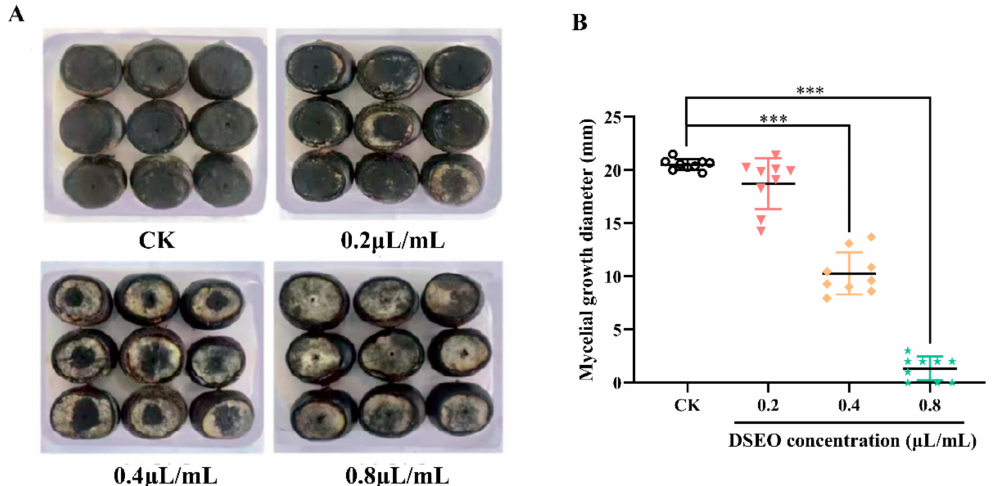
Figure 9. In vivo fumigation antifungal activity of DSEO on the growth of N. parvum . ( A ) Represen- tative photos of chestnut samples with or without DSEO treatment during 3 days of incubation and the mycelium length were observed by using the adsorption of activated carbon; ( B ) The effect of DSEO on the growth length of mycelium, n = 9. “CK” represents “control”. Statistical significance